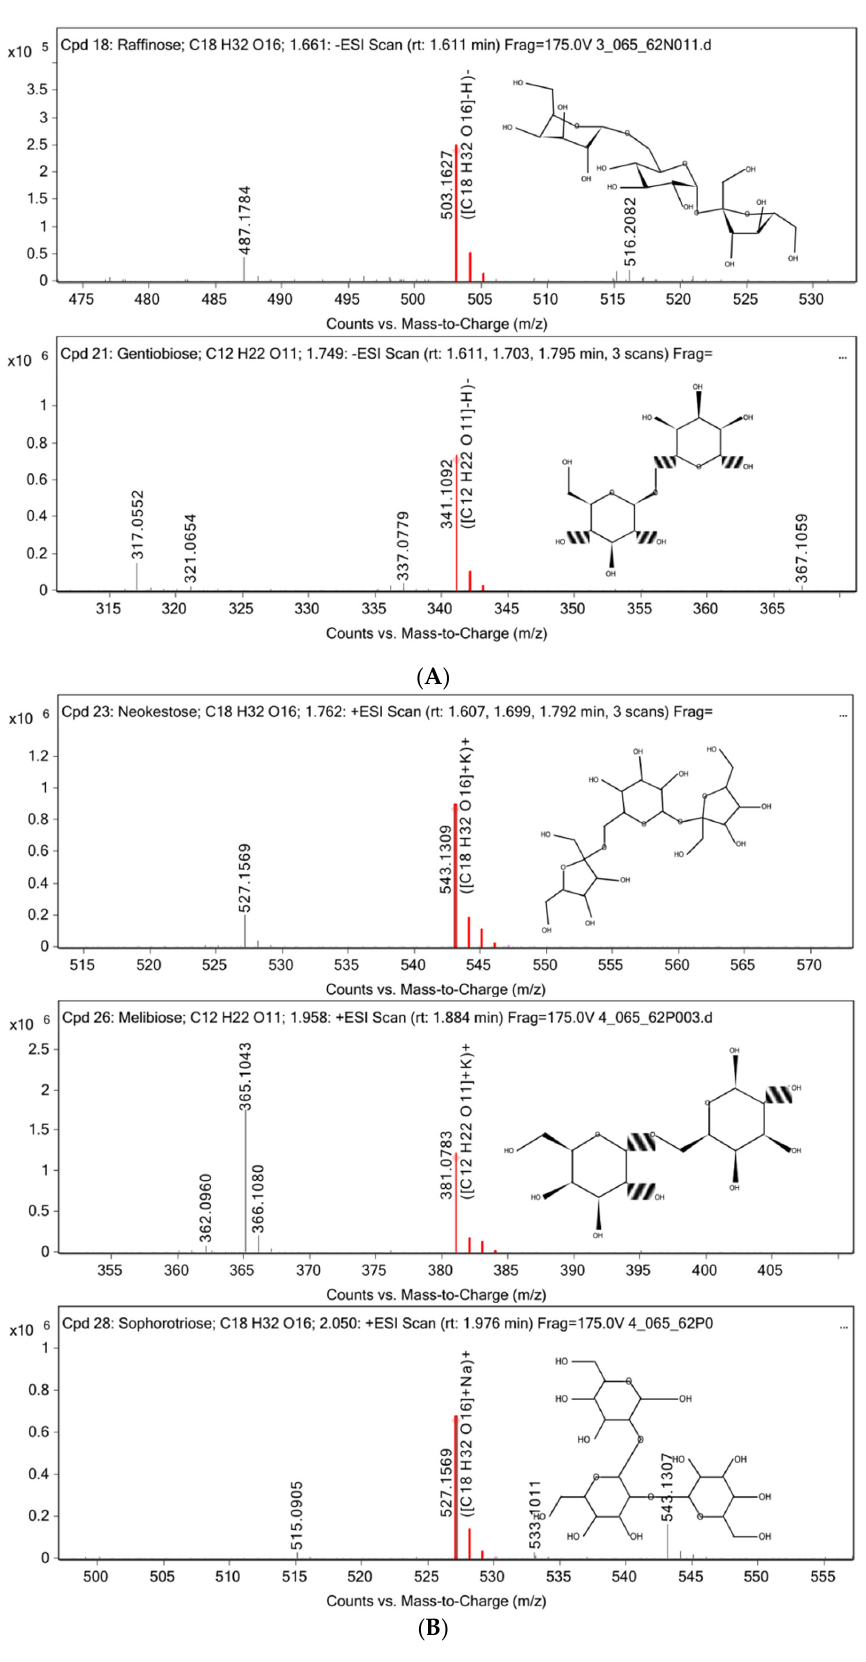
Figure 4. Mass spectrum of raffinose and gentiobiose from − ESI mode ( A ). Neokestose, melibiose, and sophorotriose from +ESI mode ( B